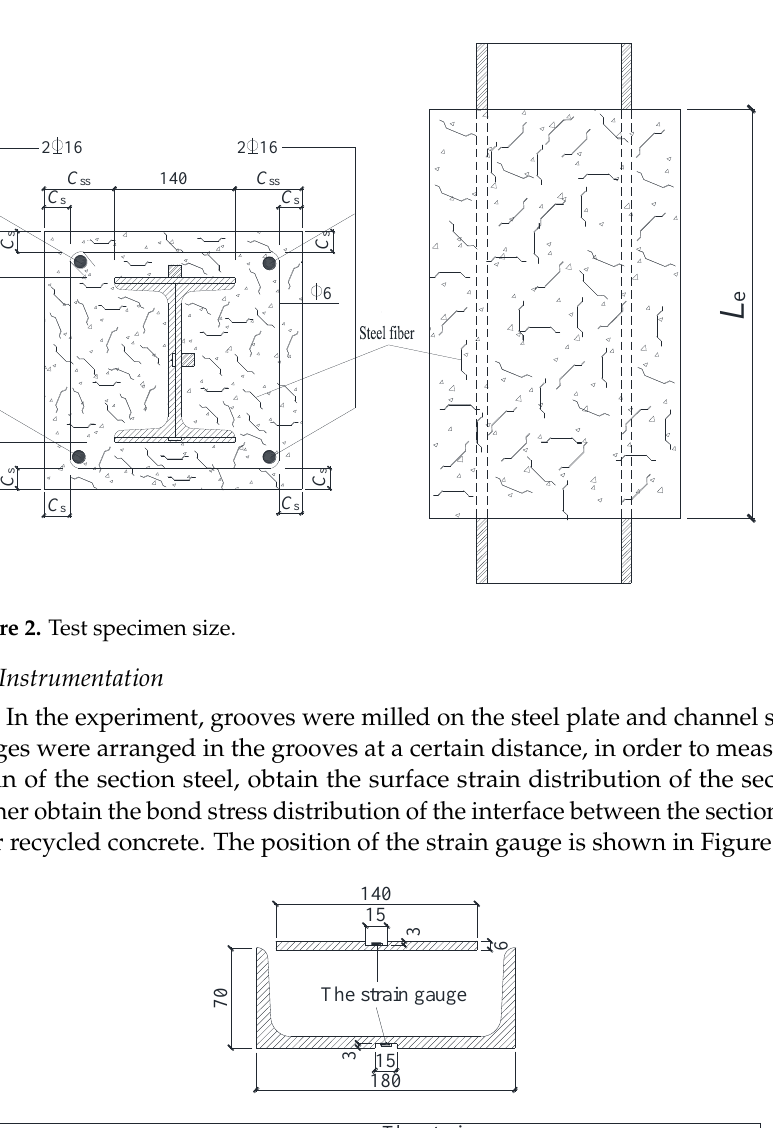
Figure 2. Test specimen size.